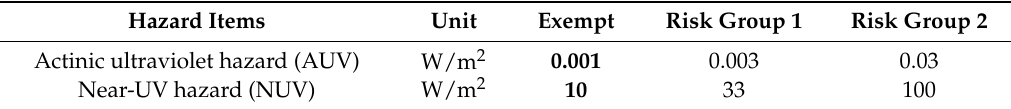
Table 2. IEC 62471 classification standard for ultraviolet (UV) risk